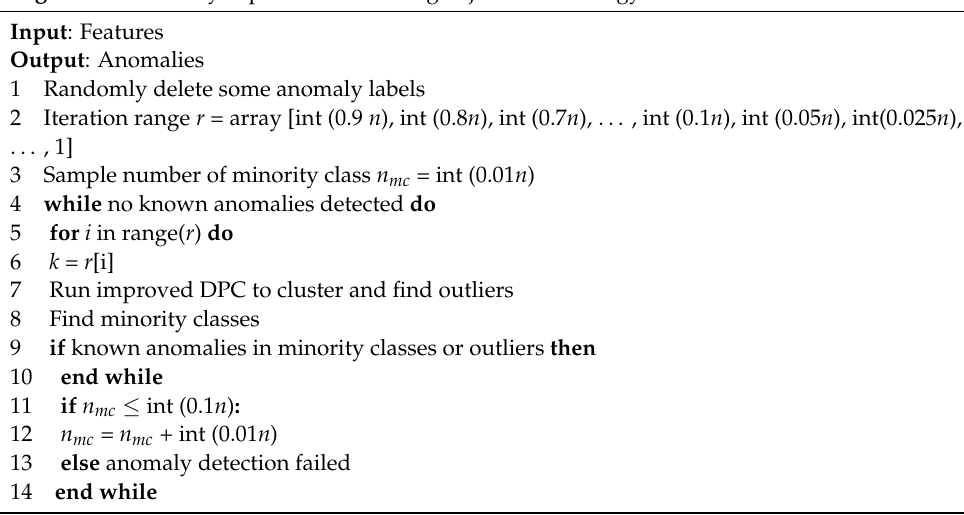
Algorithm 1. Weakly supervised clustering adjustment